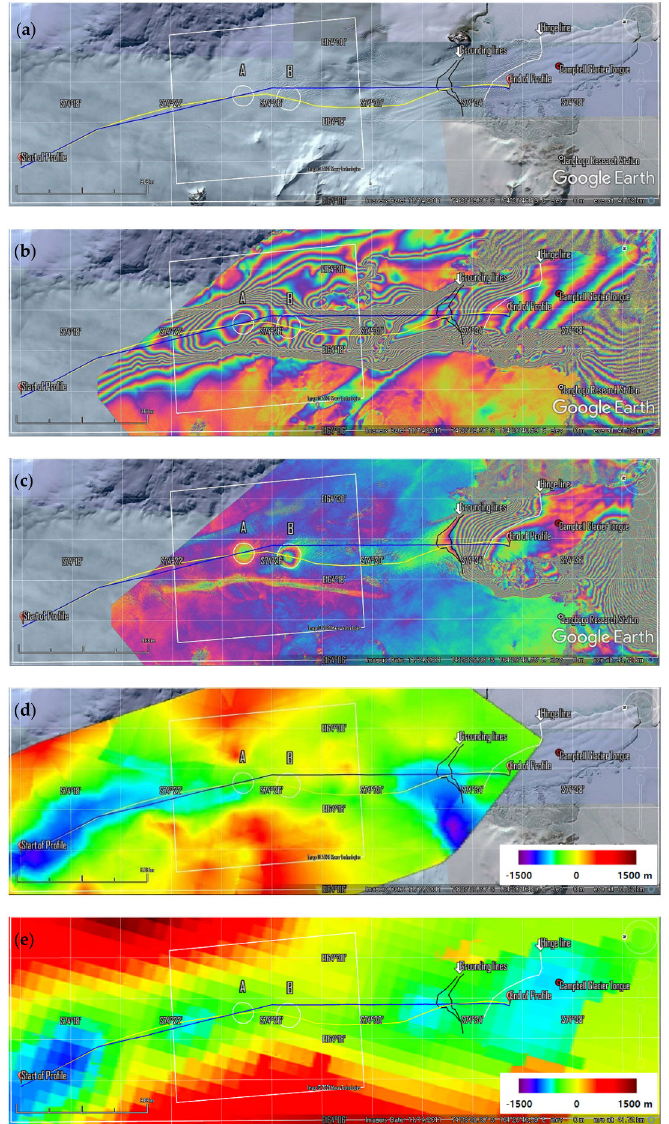
Figure 6. Surface and bed images of Campbell Glacier: ( a ) Google Earth image; ( b ) DInSAR image; ( c ) DDInSAR image; ( d ) IRP-derived bed topography; and ( e ) Bedmap2-derived bed topography. The yellow profile line is along the fastest ice-velocity in the glacier valley, while the blue line is one of the IPR survey line that crosses the anomalies A and B depicted as circles. The white box is the extent of Figure